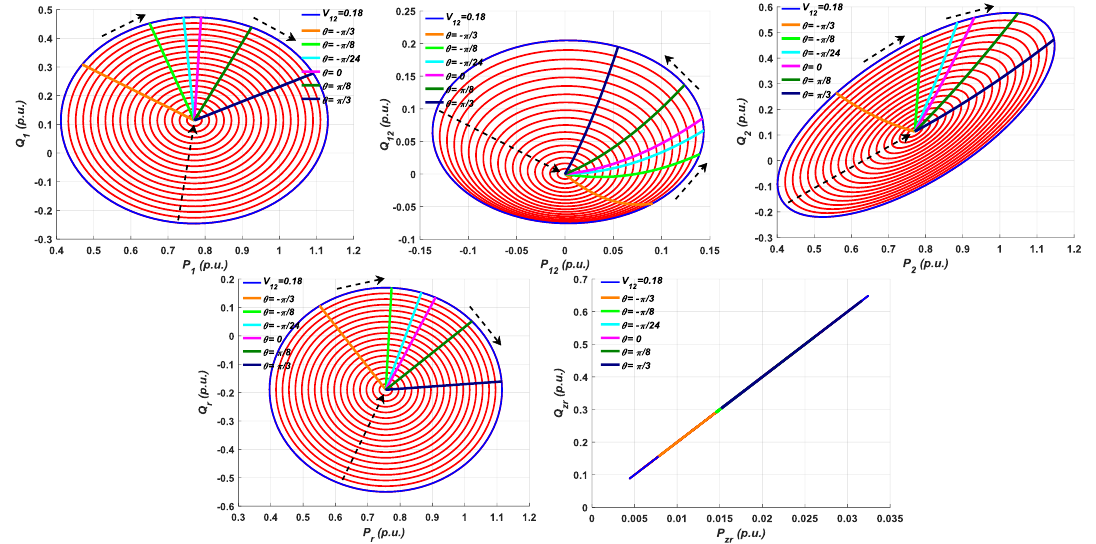
Figure 3. The 2-dimensional power flow operation planes of each part when V r =1, δ = – π /8.